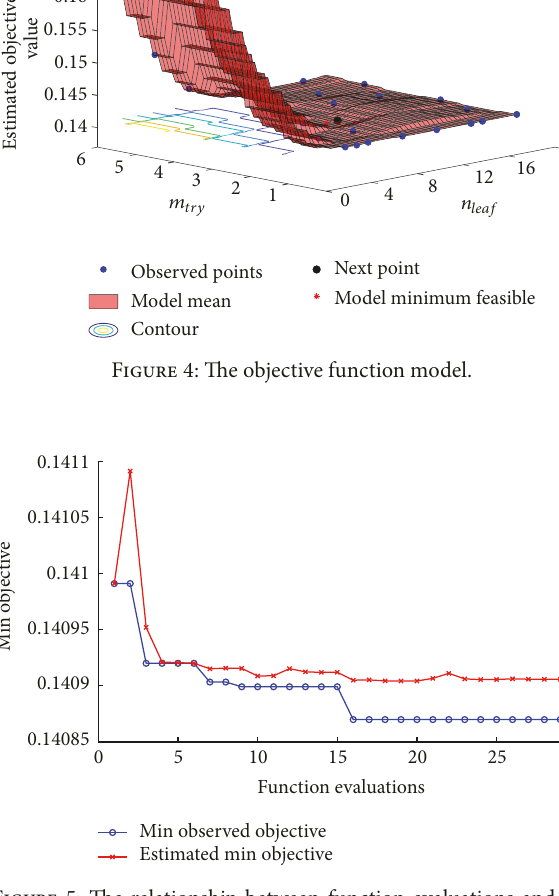
Figure 5: The relationship between function evaluations and the minimum